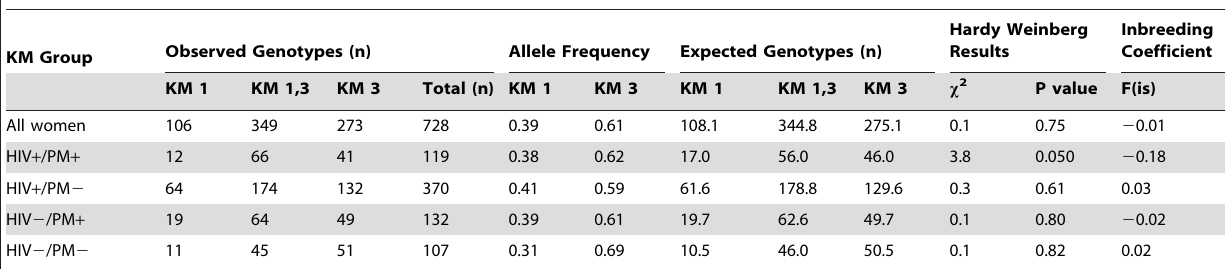
Table 7. Hardy-Weinberg Equilibrium Test for KM